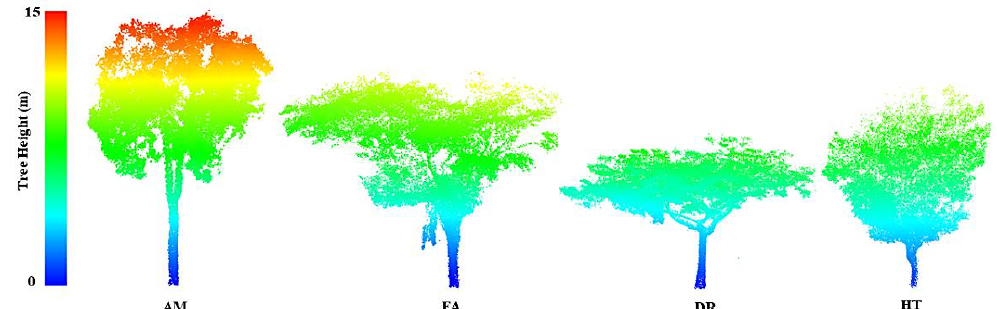
Figure 1. Location of research area and distribution of trees of selected four species. The colored icons in the dashed red circle indicate the general location of the selected four species. The icons in the solid red circle are specific sample locations of each species.